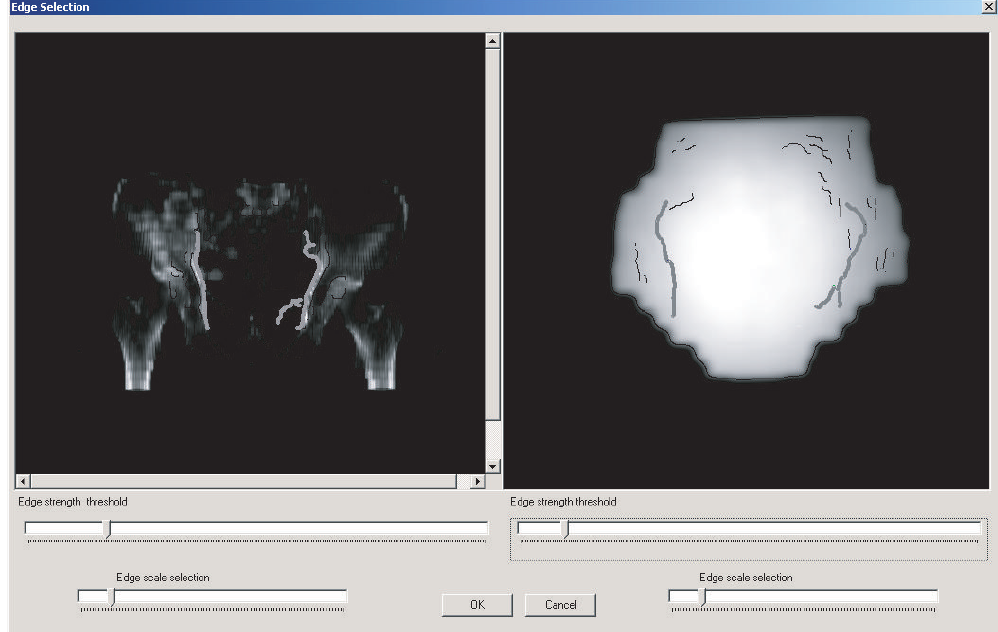
Figure 2: The edge selection window for matching the anatomical structures between a DRR and a portal